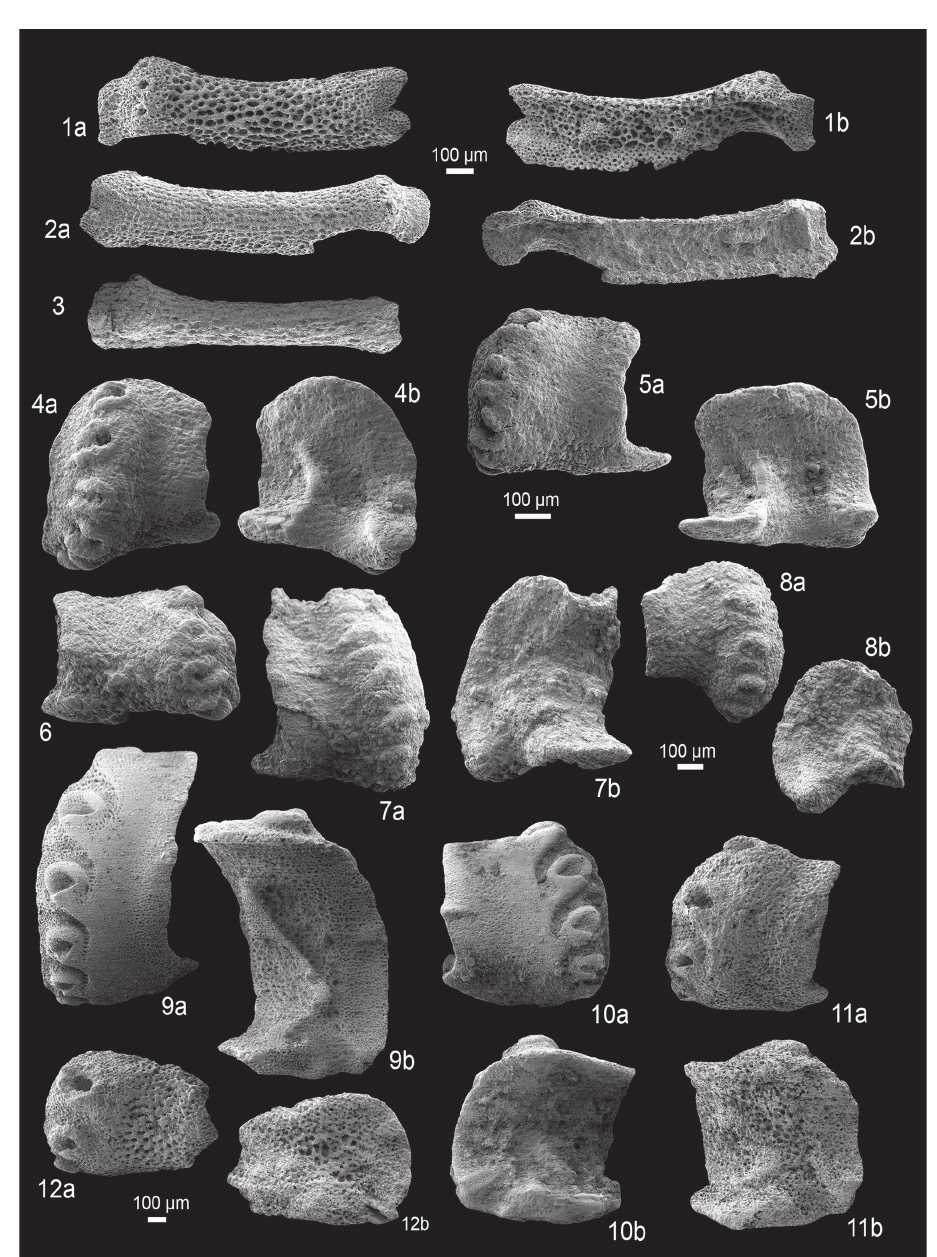
Fig. 15. Fossil lateral arm plates (LAPs) of ophiacanthid brittle stars in external (a) and internal (b) views. 1-3. Geromura teckliformis gen. et sp. nov. from the late Valanginian (Early Cretaceous) of the Ternberg Nappe, Austria. 1. NHMW 2012/0138/0005 (holotype), proximal LAP. 2. NHMW 2012/0138/0006 (paratype), median LAP. 3. NHMW 2012/0138/0007 (paratype), distal LAP. 4-6. Krohcoma mira gen. et sp. nov. from the late Sinemurian to early Pliensbachian (Early Jurassic) of the Glasenbach Gorge, Austria. 4. NHMW 2012/0137/0013 (holotype), proximal LAP. 5. NHMW 2012/0137/0014 (paratype), median LAP. 6. NHMW 2012/0137/0015 (paratype), distal LAP. 7-8. Krohcoma sp. nov. innom from the late Bathonian (Middle Jurassic) of Jumara, India. 7. GZG.INV.78574, proximal LAP. 8. GZG.INV.78575, median to distal LAP. 9-12. Krohcoma ampla gen. et sp. nov. from the early Kimmeridgian of the Pointe du Chay (9-10), France, and the late Kimmeridgian of Trancoso, Portugal (11-12). 9. GZG.INV.78577 (holotype), proximal LAP. 10. GZG.INV.78578 (paratype), median LAP. 11. GZG.INV.78579 (paratype), median LAP. 12. GZG.INV.78580 (paratype), distal LAP. One common scale bar per species is